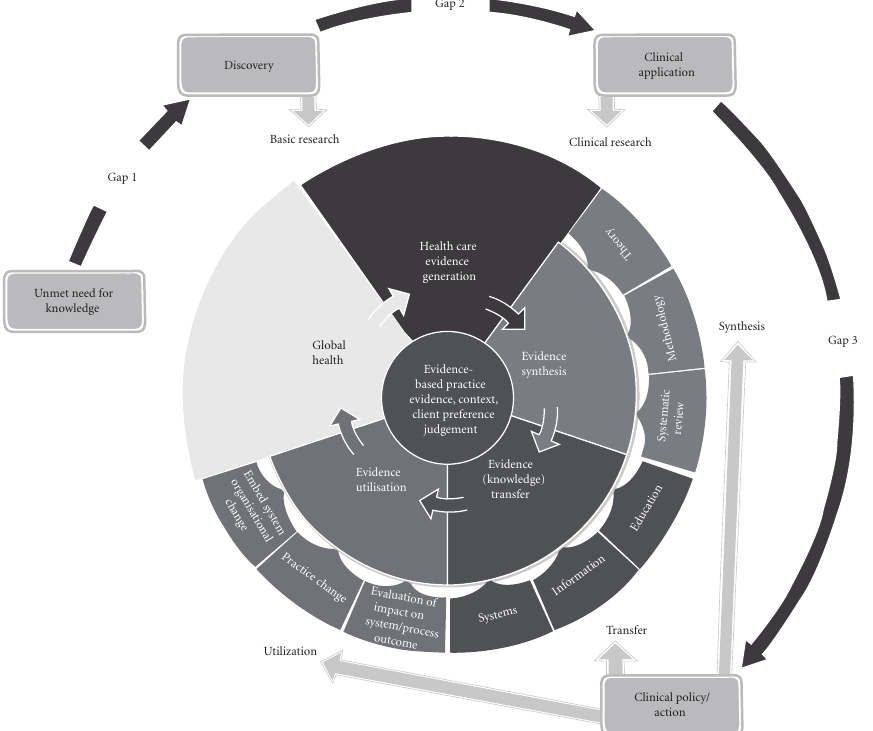
Figure 4: The relationship between the translation science cycle and evidence-based